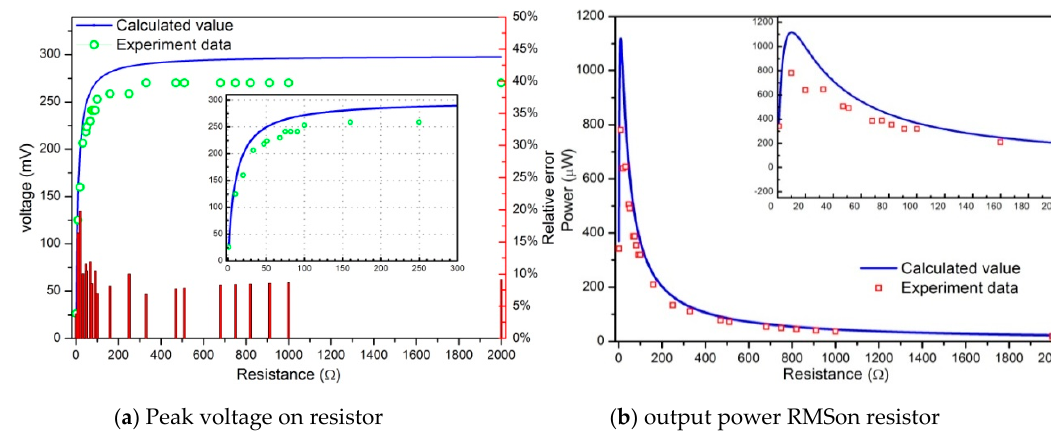
Figure 11. Output voltage and electrical power versus external resistive load at the fundamental resonance.